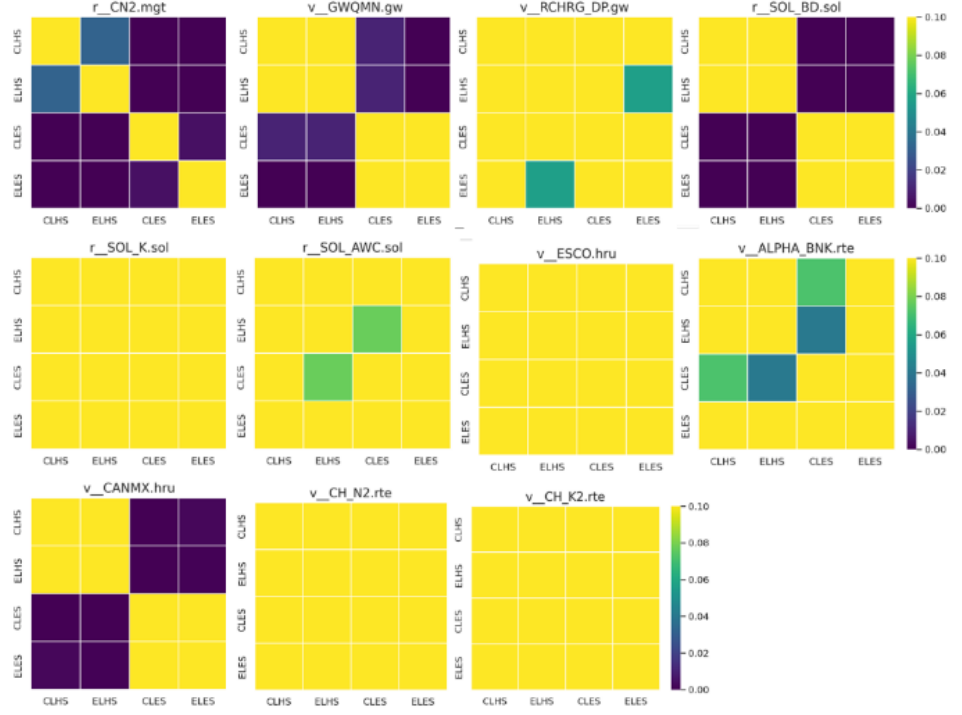
Figure 5. Crosswise comparison of model parameter ranges with p -values of the Mann–Whitney-U test in the joint parameter uncertainty analysis with the common parameter list. Statistical significance ( p < 0.05, dark-green to purple) indicates we can reject the null hypothesis that states the two groups are